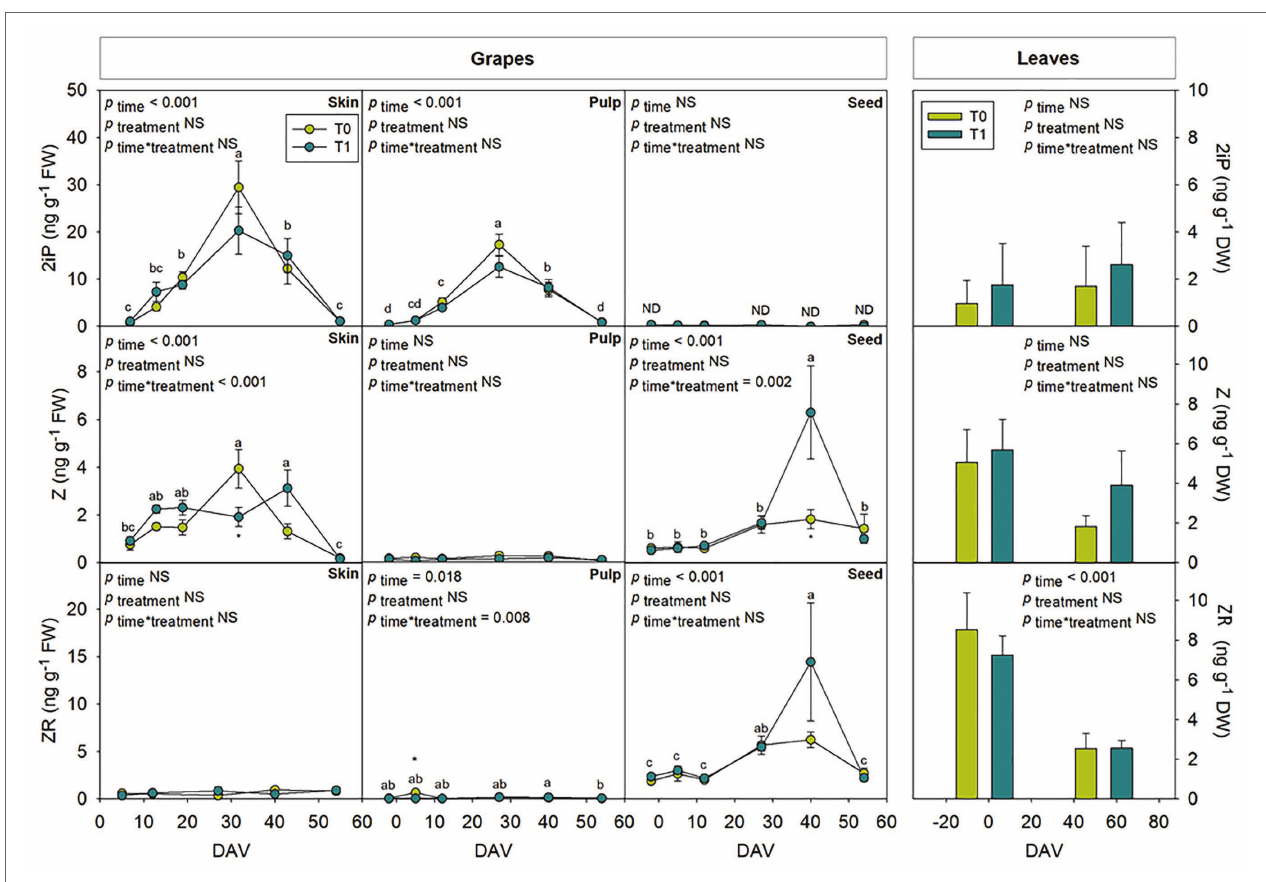
FIGURE 8 | Tissue-specific endogenous variations in cytokinins in berries of “Merlot” grapes during ripening in non-irrigated (T0) and irrigated (T1) vineyards. 2-isopentenyl adenine (2iP), isopentenyl adenosine (IPA), trans -zeatin (Z) and trans -zeatin riboside (ZR) contents in grape tissues, including the skin, pulp and seeds throughout ripening. Hormonal contents in leaves at the beginning and the end of the season are shown for comparison. Vertical bars indicate SE of six replicates. Different letters denote significant differences among sampling dates (Tukey’s HSD post-hoc test p < 0.05). The asterisks indicate statistically significant differences between treatments ( p <